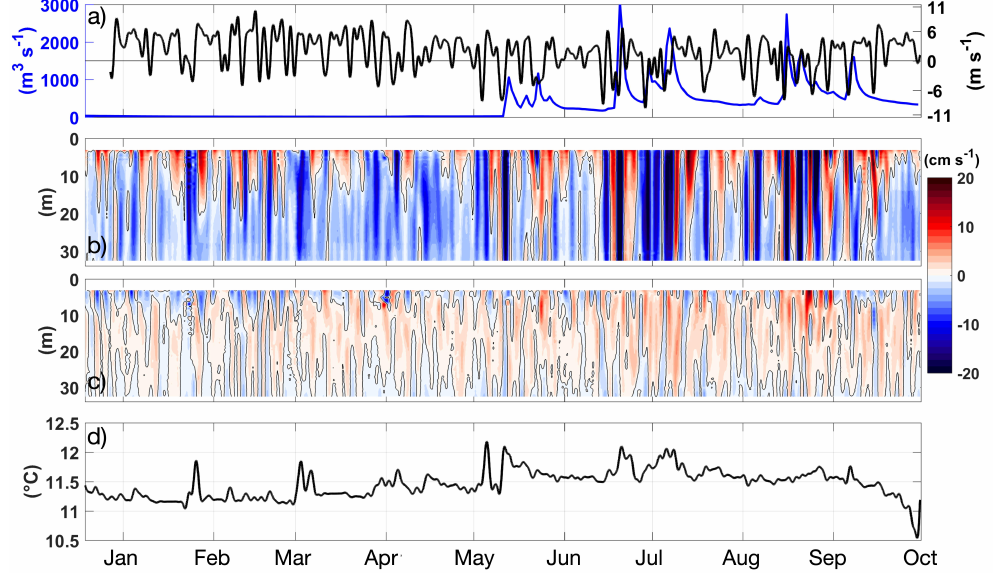
Figure 6. Synoptic time series of ( a ) alongshore wind at Hualpen Point (black line) and Itata River discharge (blue line), ( b ) alongshore flow, ( c ) cross-shore flow, and ( d ) bottom temperature off the Itata River mouth. Currents and bottom temperature are obtained from the mooring in the vicinity of the river mouth (see Figure 1).